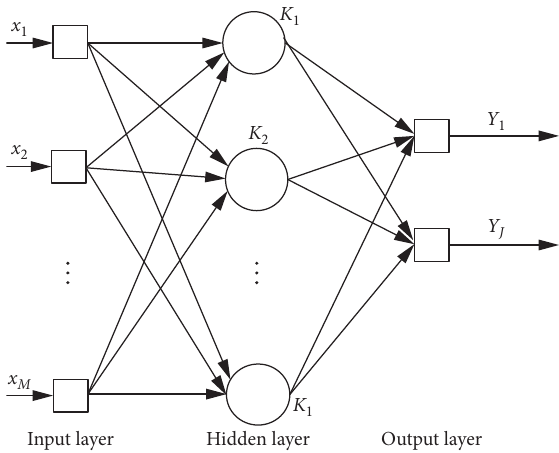
Figure 1: Three-layer BP network